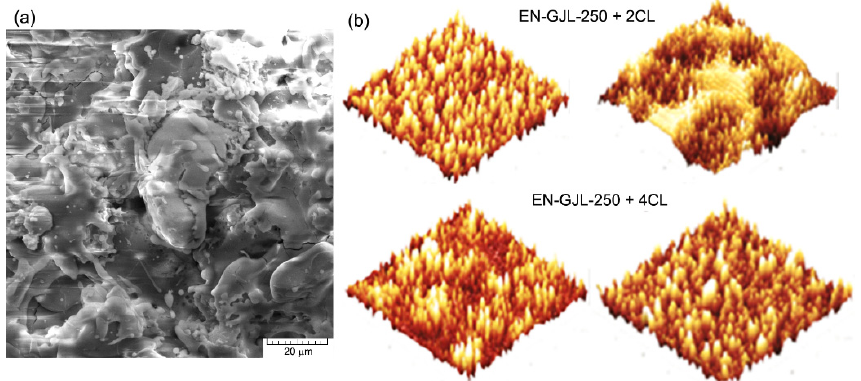
Figure 2. SEM images, in ( a ) and AFM, in ( b ) for the ceramic deposited coating.